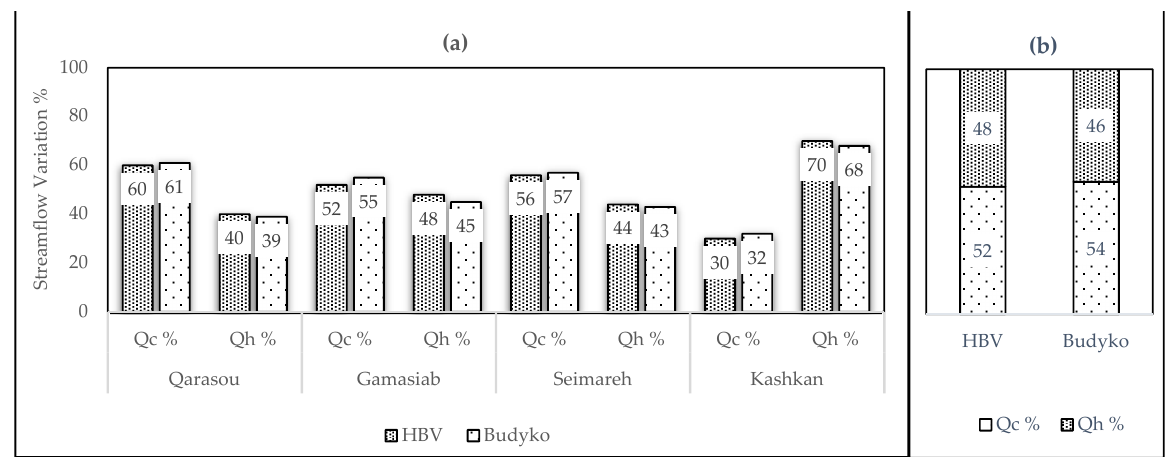
Figure 4. ( a ) Percentage of streamflow (Q) changes for all sub-basins due to climate variability and human activities. ( b ) Cumulative percentage of streamflow variation (%) for the entire KRB due to climate variability and human impact. c and h indicate climate variation and human activities, respectively.